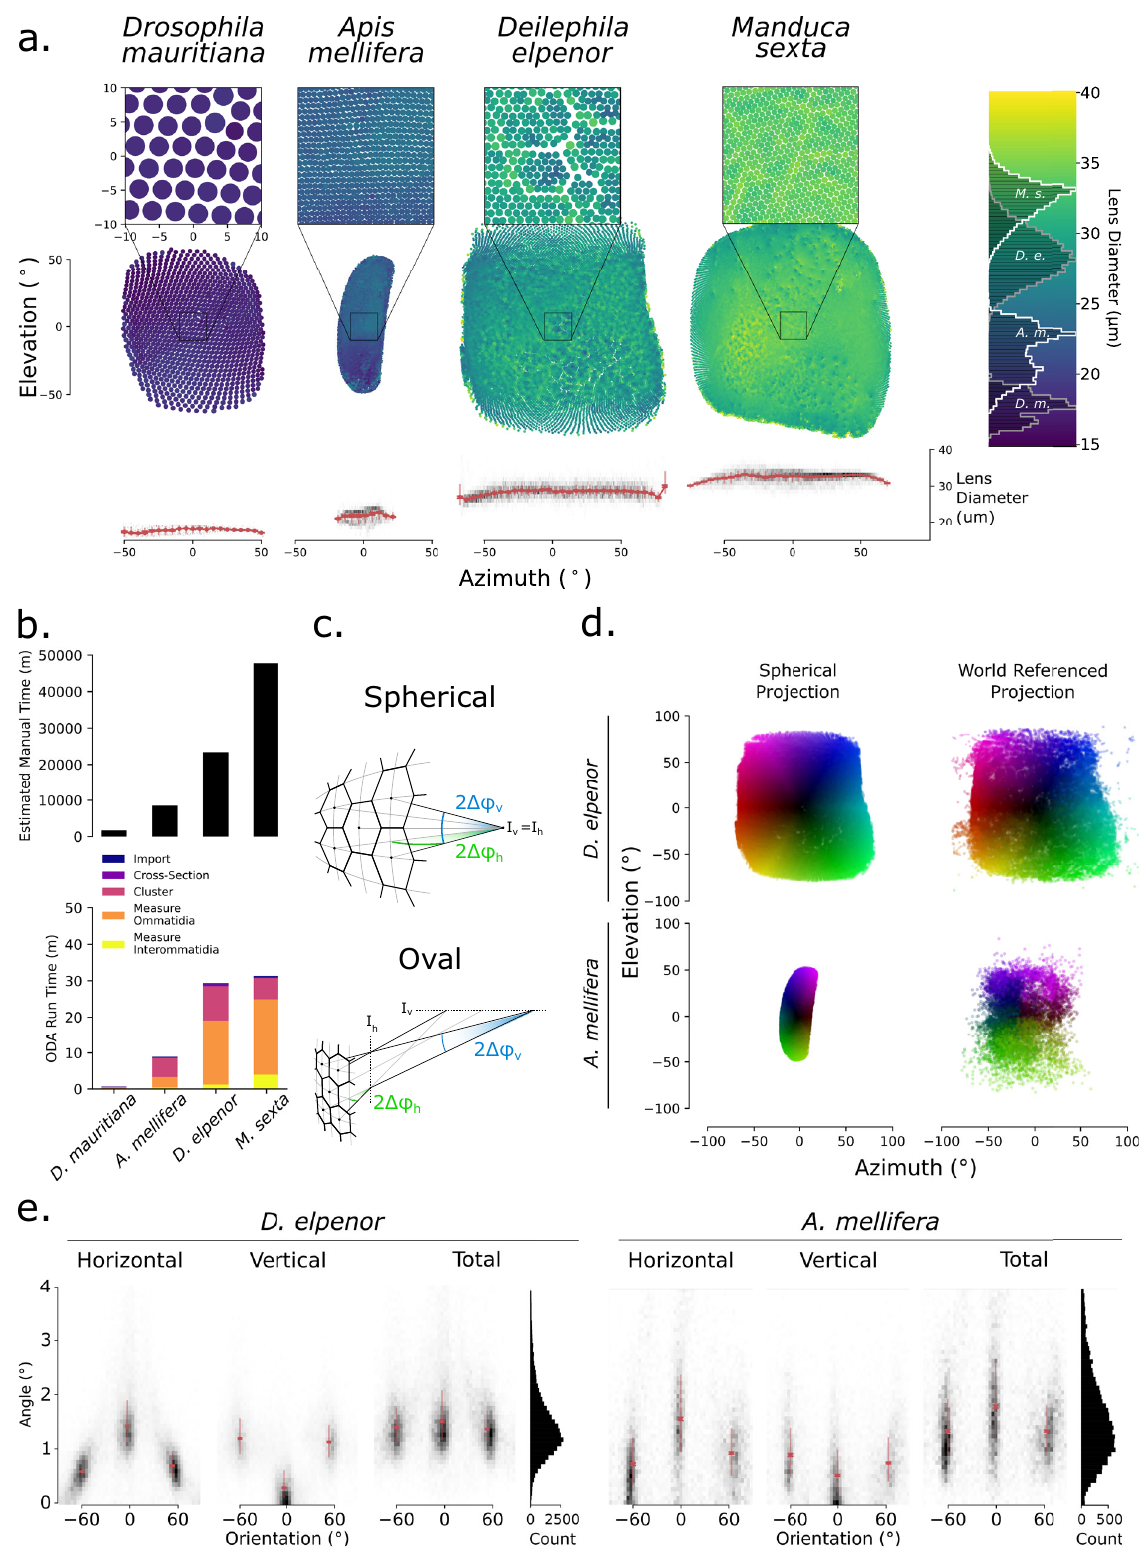
honeybee scan, including features of an oval eye and projecting onto world-referenced